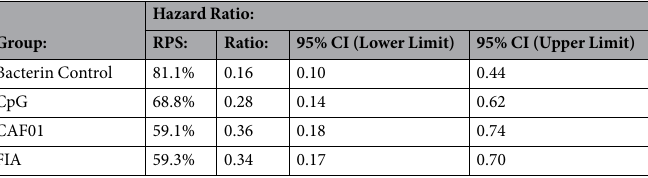
Table 3. Relative percent survival and hazard ratio results from the experimental